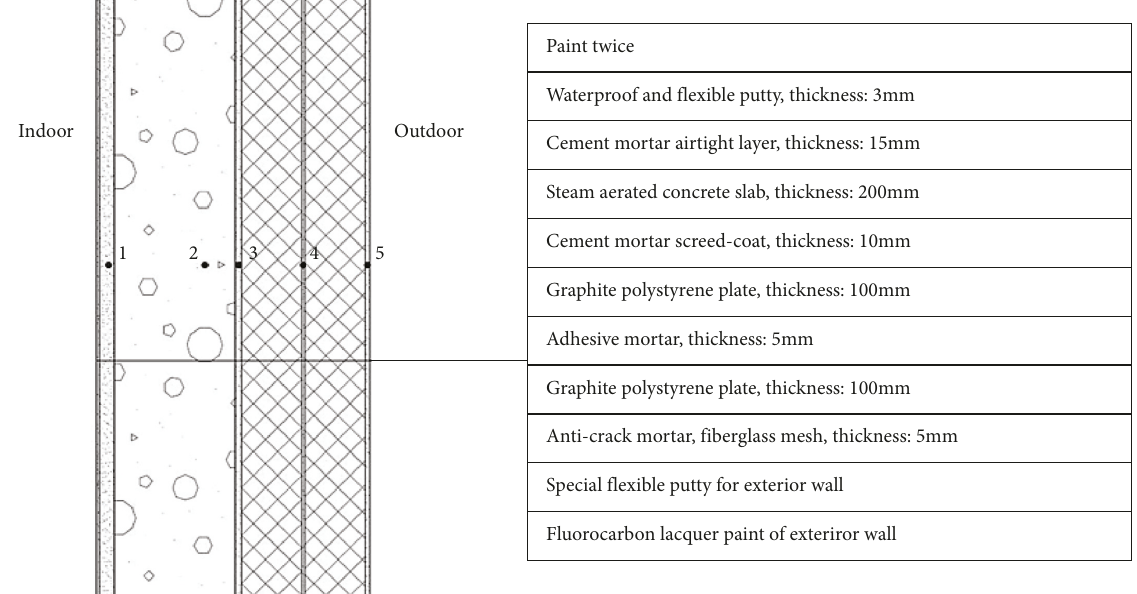
Figure 2: The structure of the test wall and the location of temperature and humidity measurement points in the wall. (1–5 represent the locations of temperature and humidity measurement